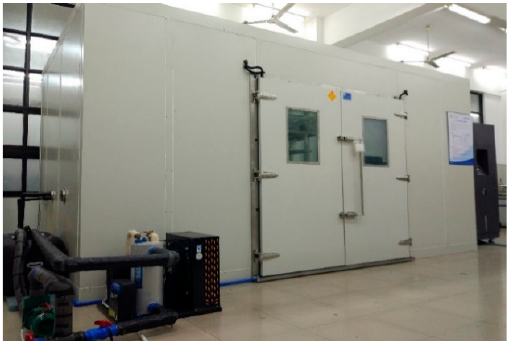
Figure 3. Image of the environmental cabinet.